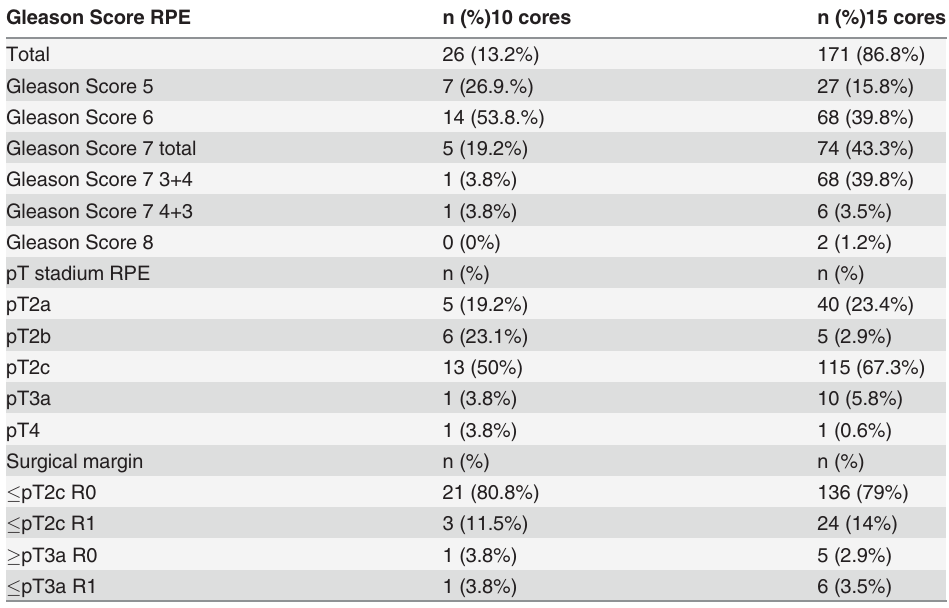
Table 8. Final GS grade and pathological tumor stage of RPE specimen sub-analyzed according to biopsy cores (10 cores versus 15 cores), Statistics: descriptive. Gleason Score